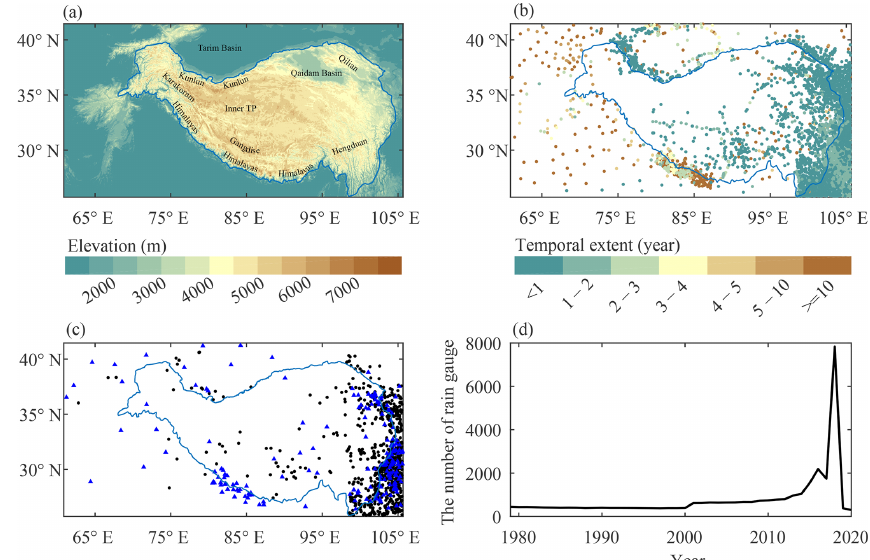
Figure 1. (a) Topography of the Third Pole region. (b) Spatial distribution of rain gauges used in this study and their temporal extent. (c) The independent rain gauges used for validation, in which rain gauges marked by both black dots and blue triangles are used in the analysis period of 1979–2020 (Sect. 4.1.2), and rain gauges marked by blue triangles are used in the analysis period of 2008–2015 (Sect. 4.2). (d) The number of available rain gauges in each year. The blue line denotes the 2500m contour of elevation, which is obtained from Zhang (2019).